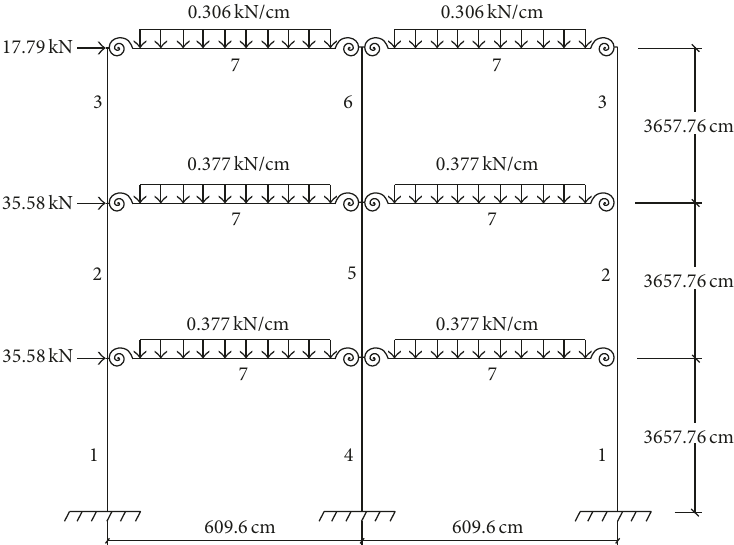
Figure 4: Unbraced steel portal frame with semirigid connections [21].